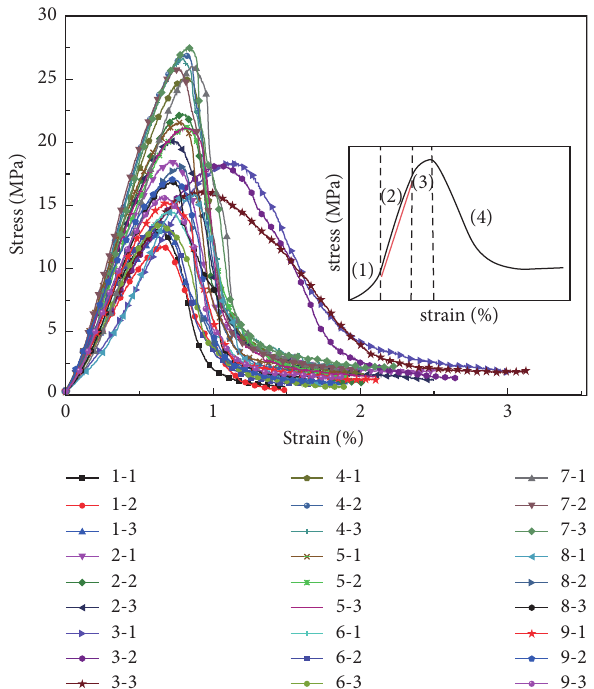
Figure 3: The stress-strain curves of the uniaxial experimental results. Inset: a schematic to show the four stages of a typical stress-strain curve. The red line is a reference line to indicate a linear relationship of stage 2. Table 3: Mechanical properties of the geopolymer samples from uniaxial compression experimental results.